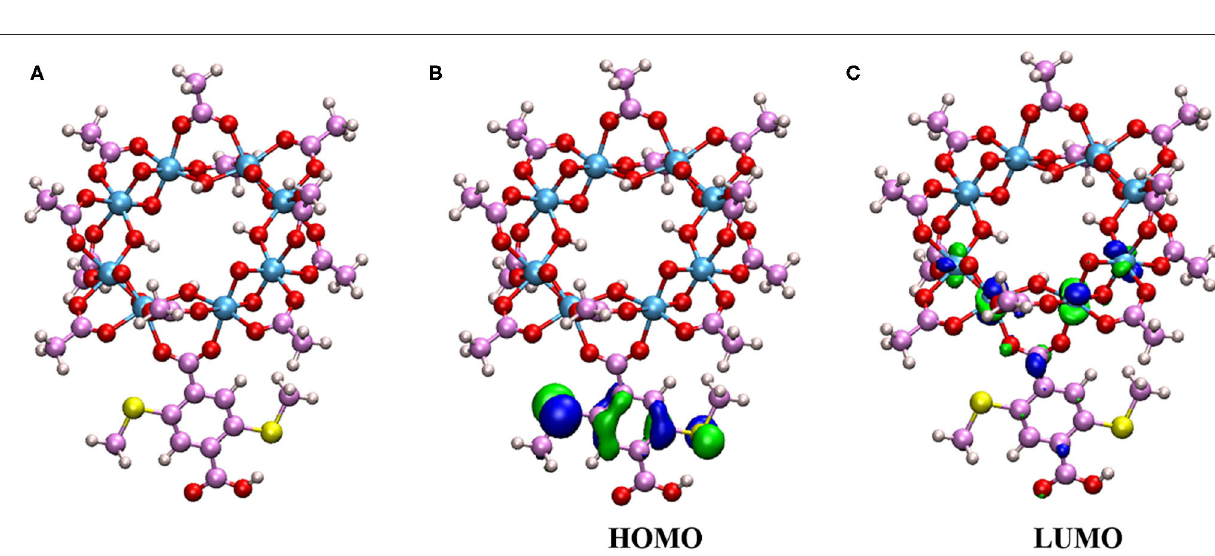
the situation is relatively similar in our system. Although the Pt atoms are not directly doped into the 20%-MIL-125-(SCH 3 ) 2 , the Pt 13 cluster could have the same function in the current system. A partial positive charge on Pt 13 after contacting with the surface of 20%-MIL-125-(SCH 3 ) 2 can support this well. At the same time, we can also see from the Bader charge diagram